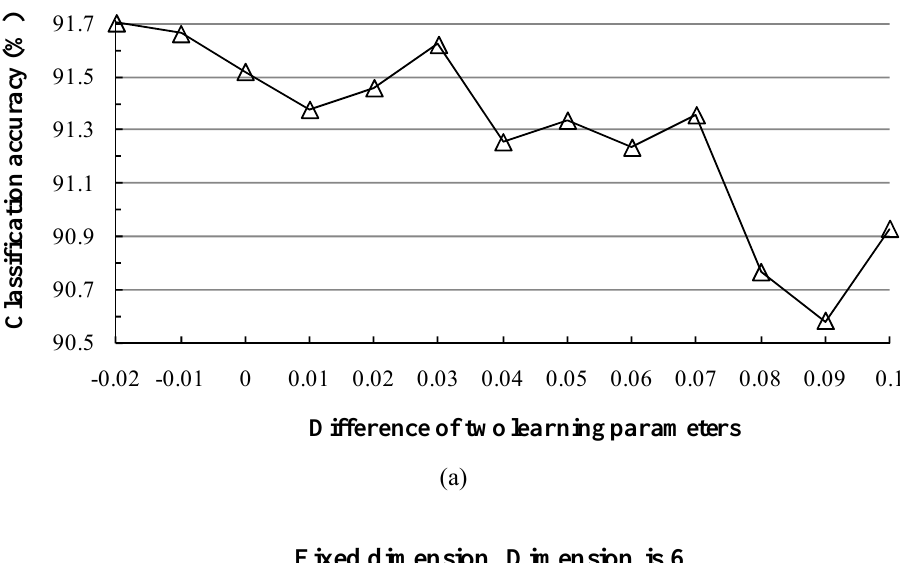
Difference of two learning parameters (a) Fixed dimension. Dimension is 6